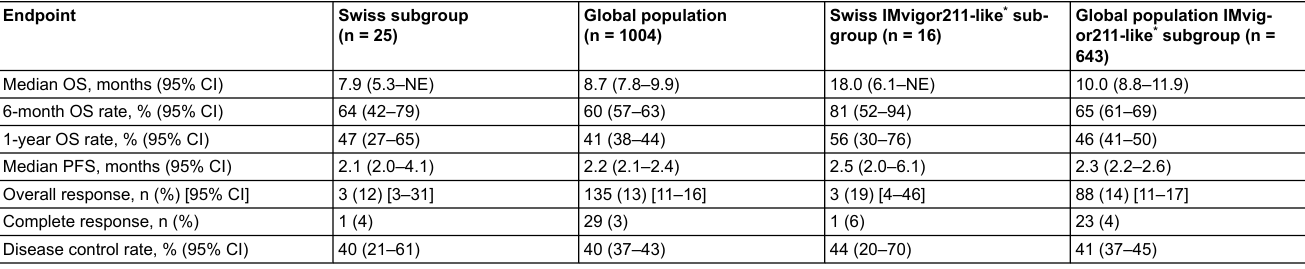
Table 3: Summary of efficacy in the Swiss subgroup and global